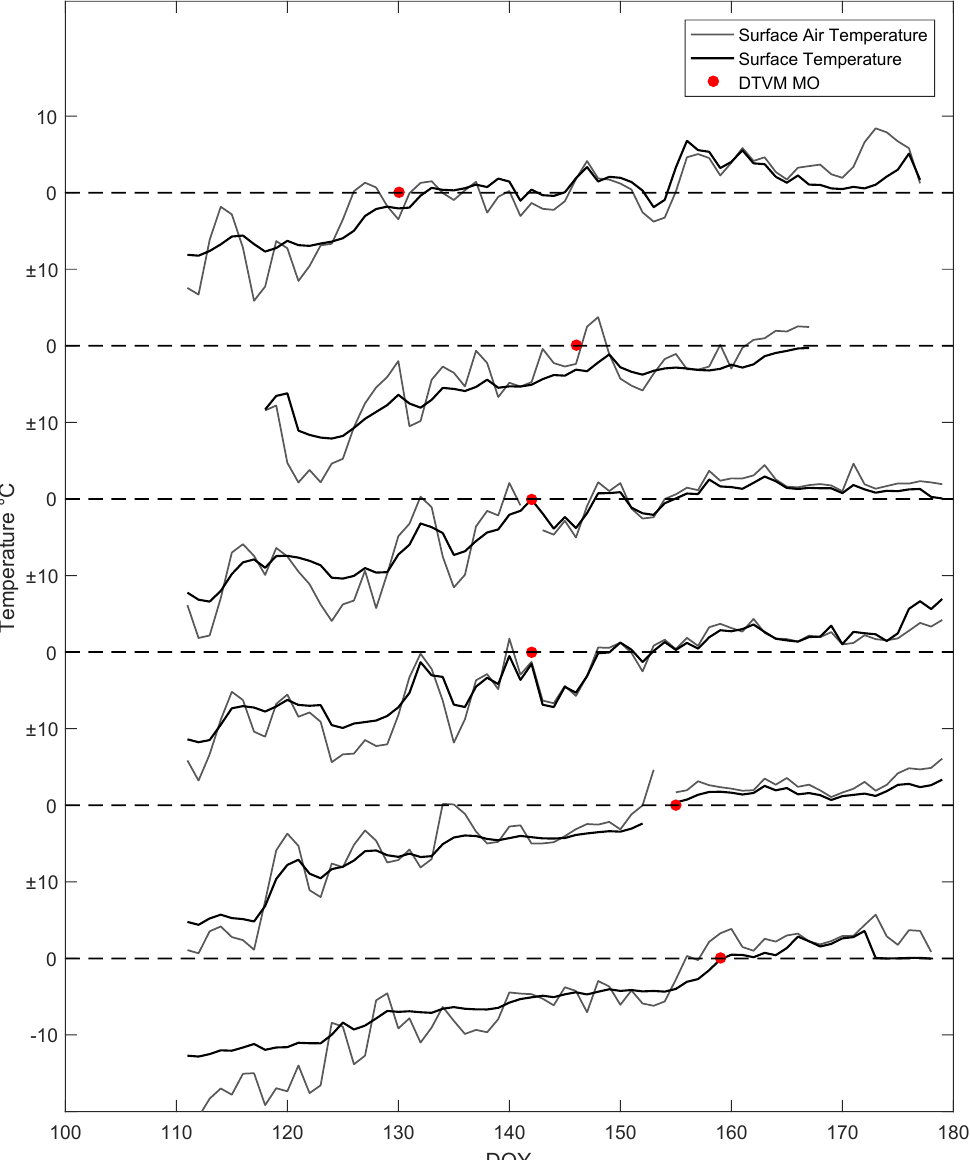
Figure 7. Snow/ice interface temperature and SAT from profilers located in the study region (locations shown in Figure 1) with MO dates from DTVM indicated. Order is profile 1–6 from top to bottom: same orientation as in Table